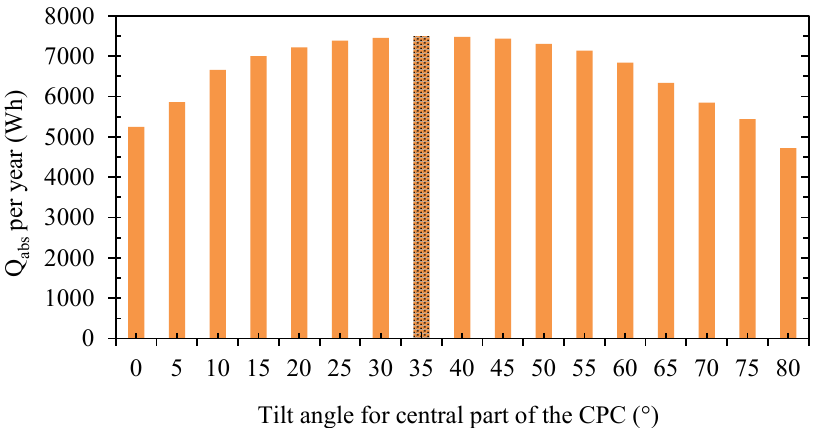
Tilt angle for central part of the CPC